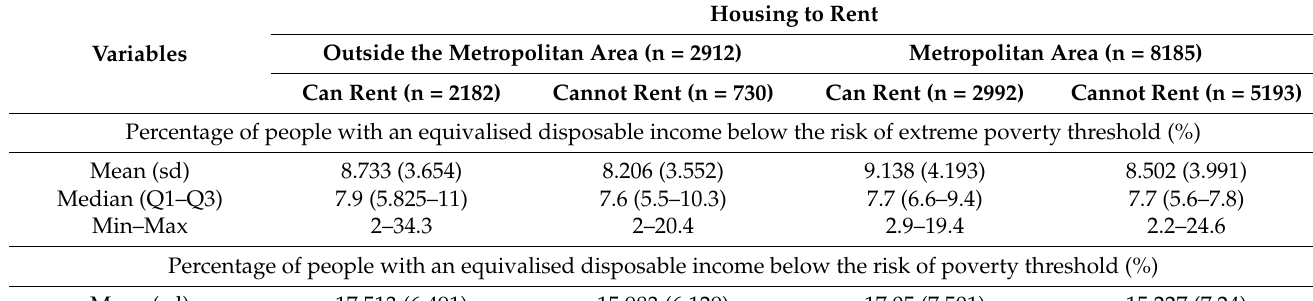
Table 2. Bivariate analysis according to the possibility of renting inside or outside the metropolitan